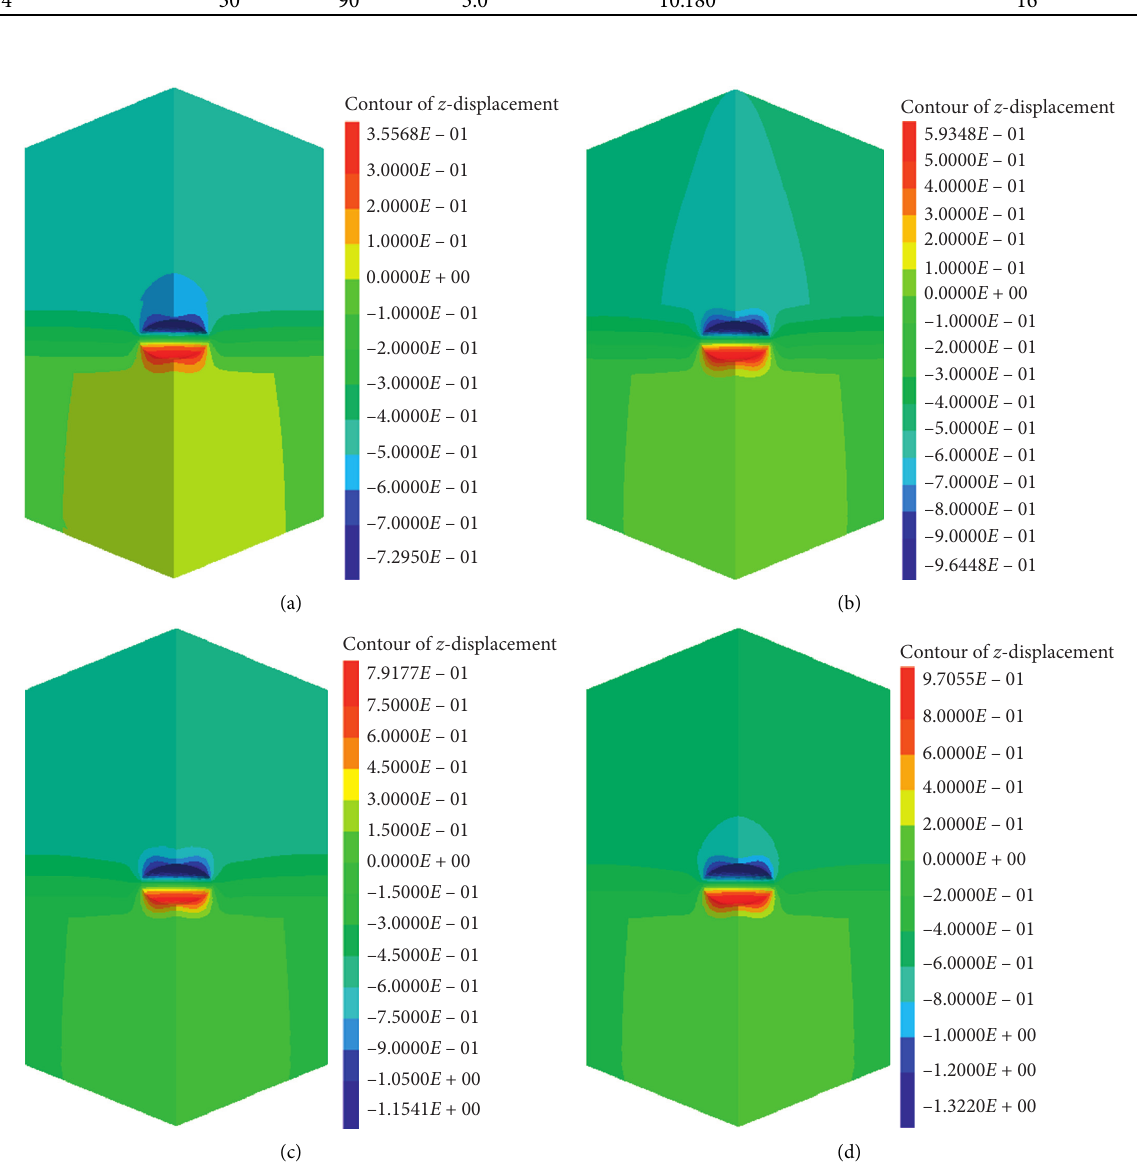
Figure 4: Cloud map of vertical displacement distribution of surrounding rock of single-cavern horizontal salt rock underground